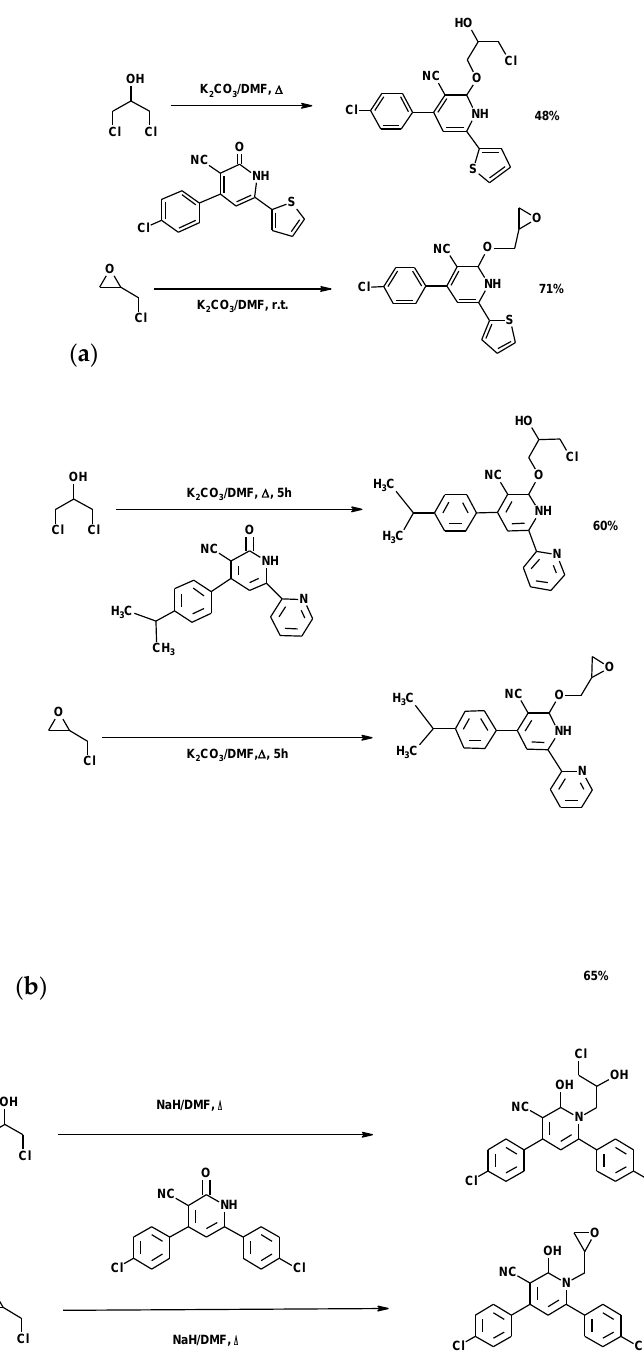
Figure 15. Synthesis of pyridine derivatives ( a ) Moustafa et al. synthesis [139]; ( b ) synthesis described by Saad et al. [140]; ( c ) Shamroukh et al. niconitrile synthesis [141].